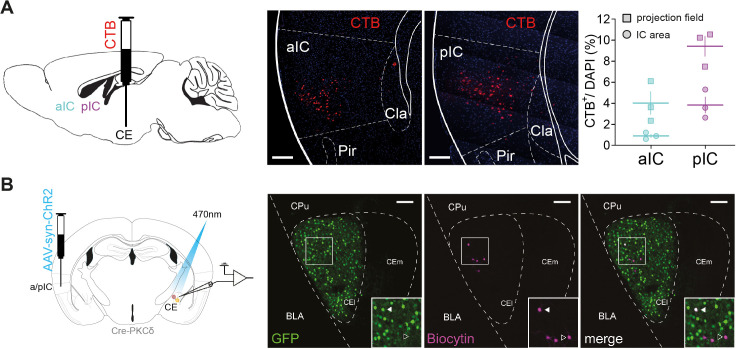
Anatomical and functional assessment of IC–CE connectivity.(A) Stereotactic injection of fluorescently labelled CTB into CE (left) with representative backlabeling in aIC and pIC (middle) and quantification (right). Each data point represents a single animal. (B) To assess synaptic connectivity between IC subregions and CE subpopulations in Figure 2A, PKCδ::Cre mice received injections of AAVs carrying Cre-dependent GFP into CE and syn-ChR2 into aIC or pIC (left). Exemplary slice showing GFP expression in CEPKCδ (green) and biocytin-filled fluorescently labelled streptavidin-stained patched neurons (magenta) (right).